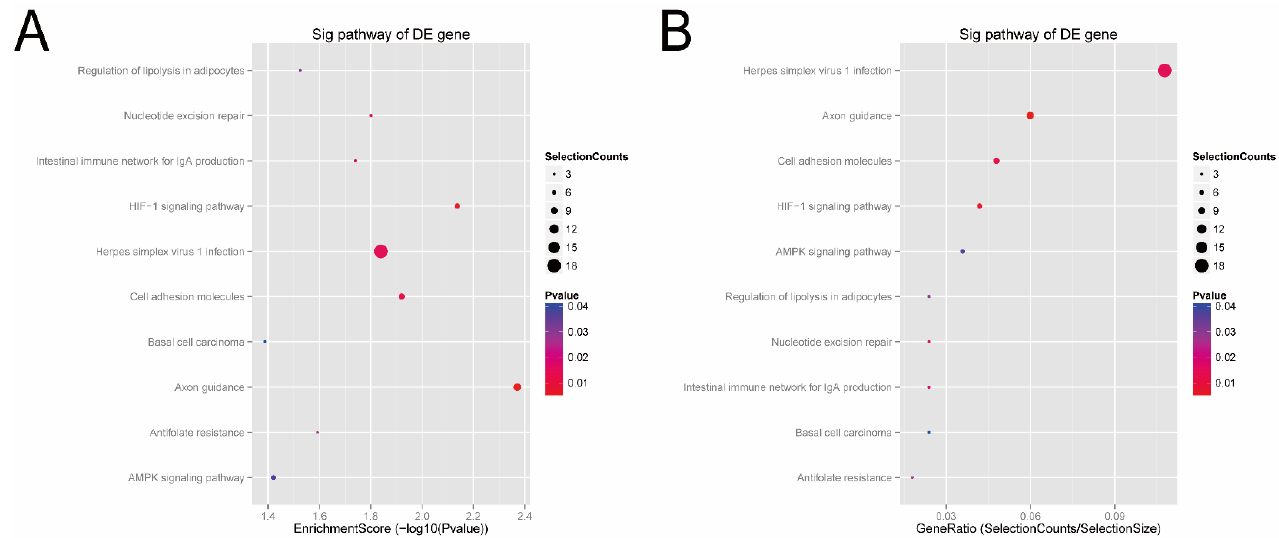
Figure 6. KEGG pathway analysis of the target genes of the four candidate tsRNAs. ( A ) Pathway dot plot explanation (enrichment score dot plot). The dot plot showed the top ten enrichment score ( − log10( p ‐ value)) value of the significant enrichment pathways. ( B ) Pathway dot plot explanation (gene ratio dot plot). The dot plot presented the gene ratio value of the top ten most significant enrichment pathways.